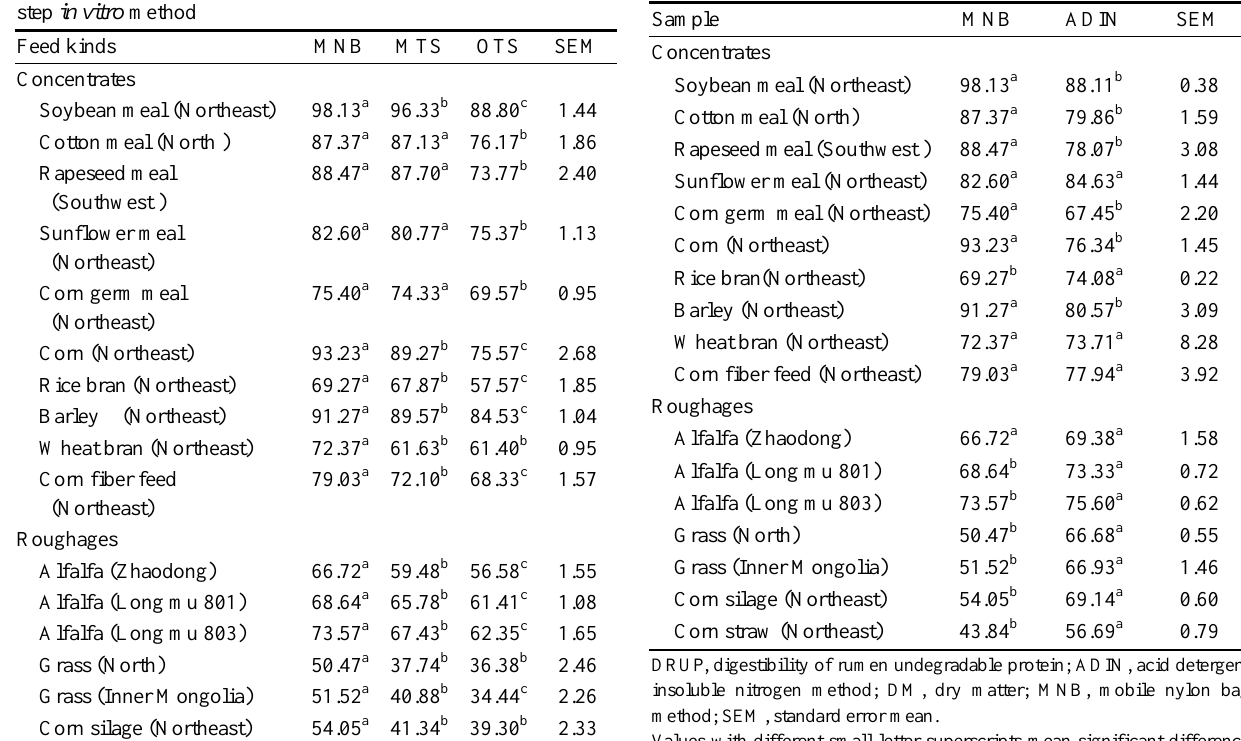
Table 3. The DRUP measured by mobile nylon method and ADIN Table 2. The feed DRUP values measured by mobile nylon bag